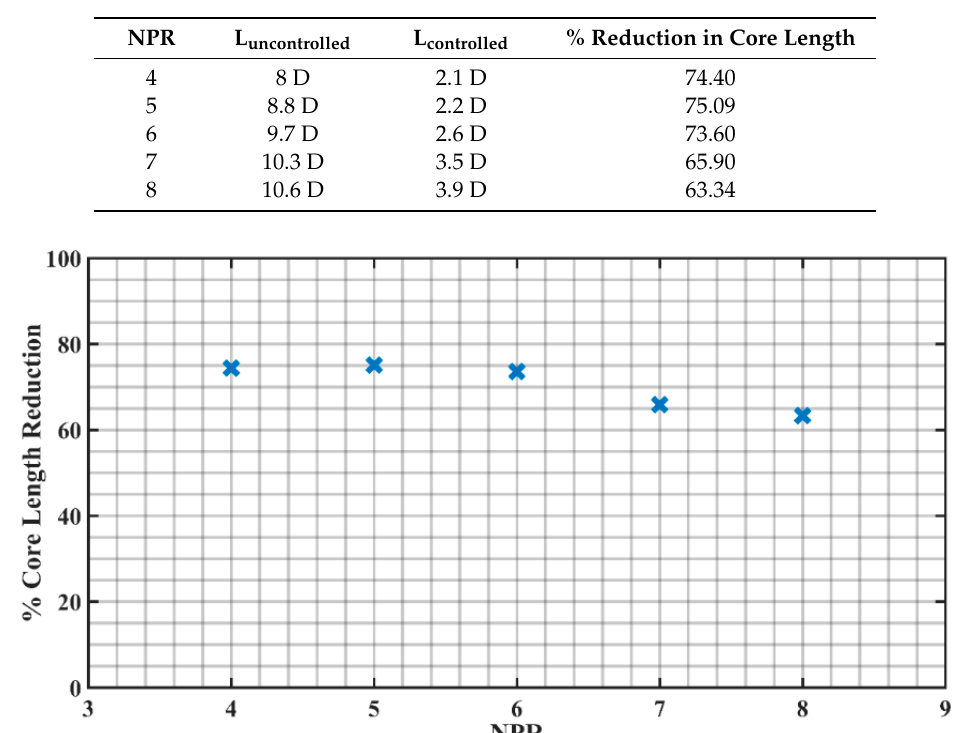
Figure 17. Figure depicting directions along and perpendicular to tab-orientation.